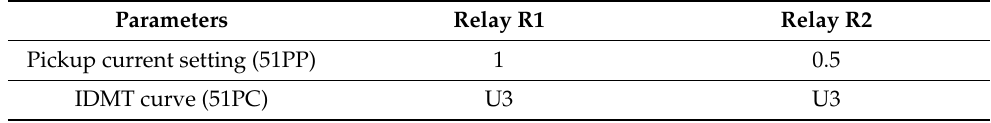
Table 1. Relay settings for coordination